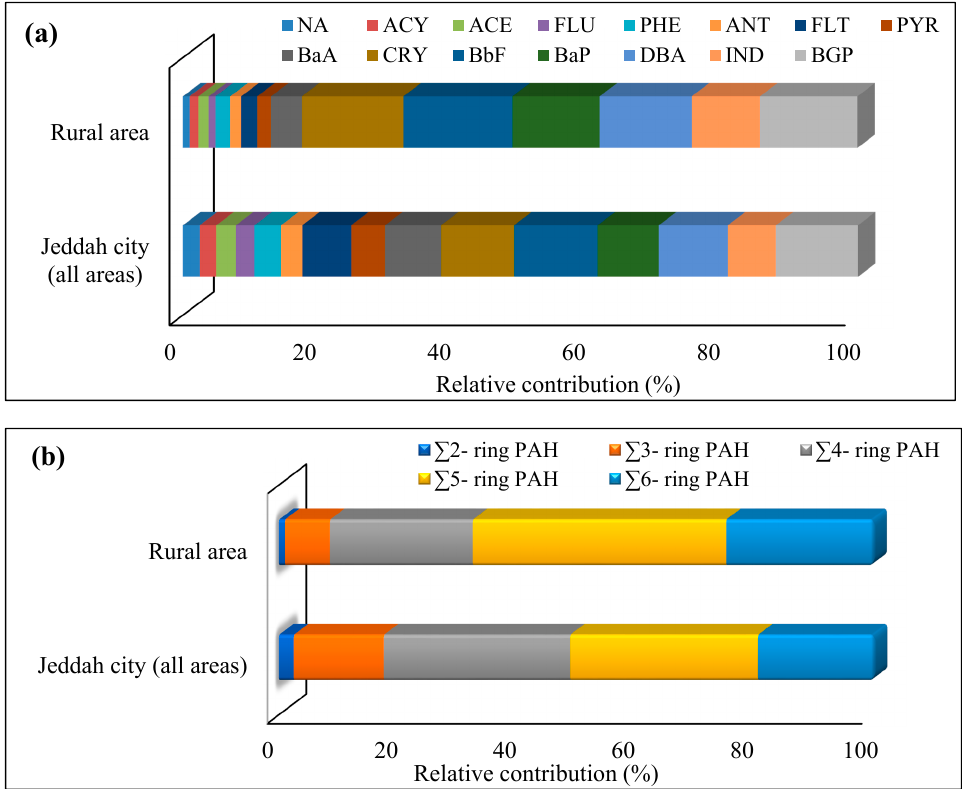
Figure 2. Relative contribution of each individual PAH compound and different categories of PAHs based on aromatic ring number to the total PAHs concentrations in street dusts collected from all areas of Jeddah city and a rural area (RUA) of Hada Al Sham: ( a ) individual PAH compounds and ( b ) two to six-ring PAHs.